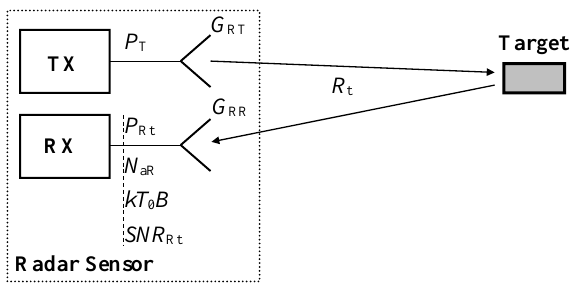
Figure 3. Sensor-target-sensor signal path with signal and noise parameters.